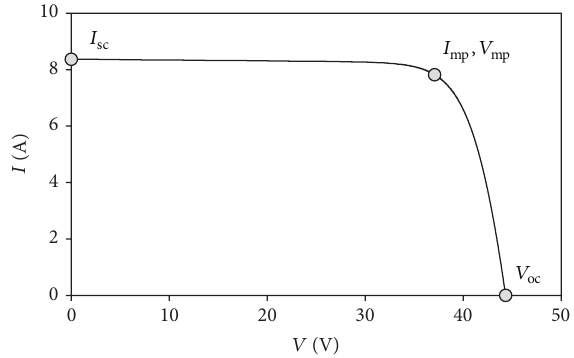
Figure 2: I - V curve of a solar panel. The three characteristic points (short-circuit, maximum power, and open-circuit points) are indicated on the